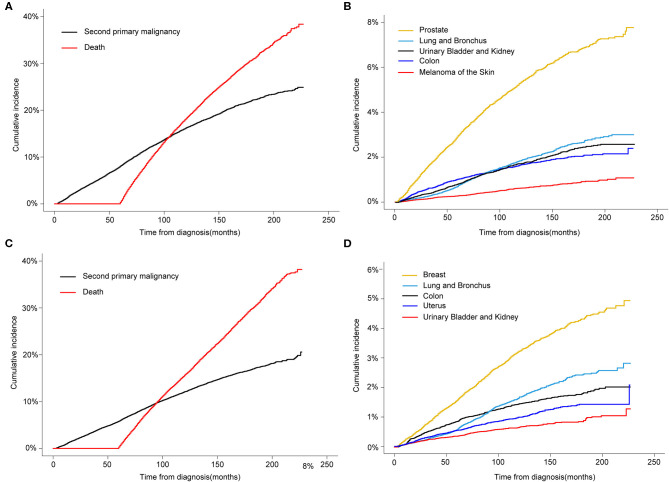
(A) Cumulative incidence of second primary malignancy (SPM) and death in male survivors based on the Gray method; (B) Cumulative incidence of top 5 SPMs sites in male survivors; (C) Cumulative incidence of SPM and death in female survivors; (D) Cumulative incidence of top 5 SPMs sites in female survivors.